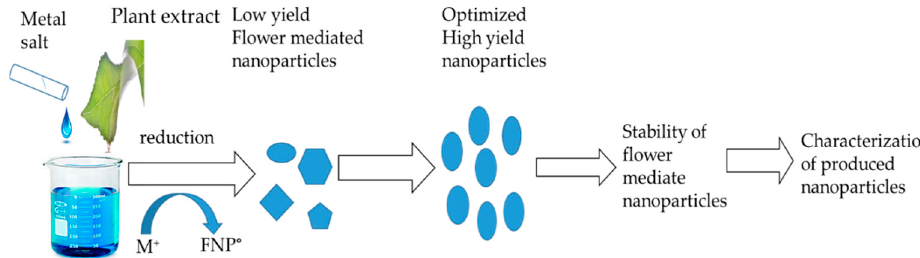
Figure 2. Mechanism of producing nanoparticles from plant extracts, modified from [41].